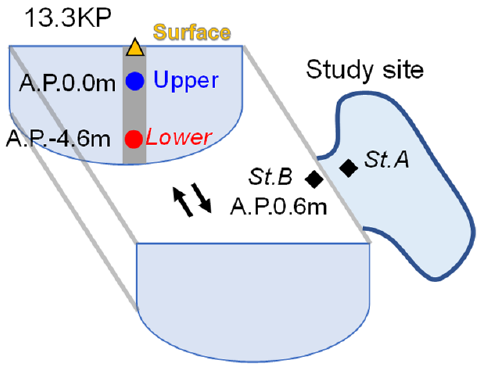
Figure 2. Observation point.